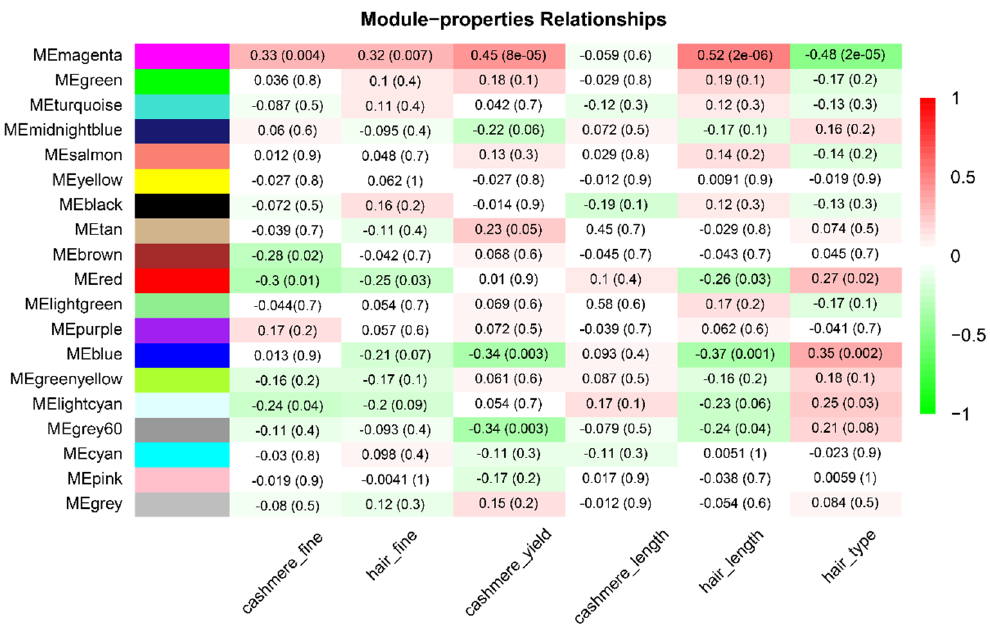
Figure 3. Module–properties relationships. Abscissa is the properties and the ordinate is the module name. The number in the grid indicates the Pearson correlation coefficient between the module and the character. The closer the value is to ± 1, the stronger the correlation between the module and the character is, and the number in parentheses represents a significant p -value. The Pearson correlation coefficient judged the correlation between module genes and phenotypic traits, and the p -value judged the significant degree of correlation.